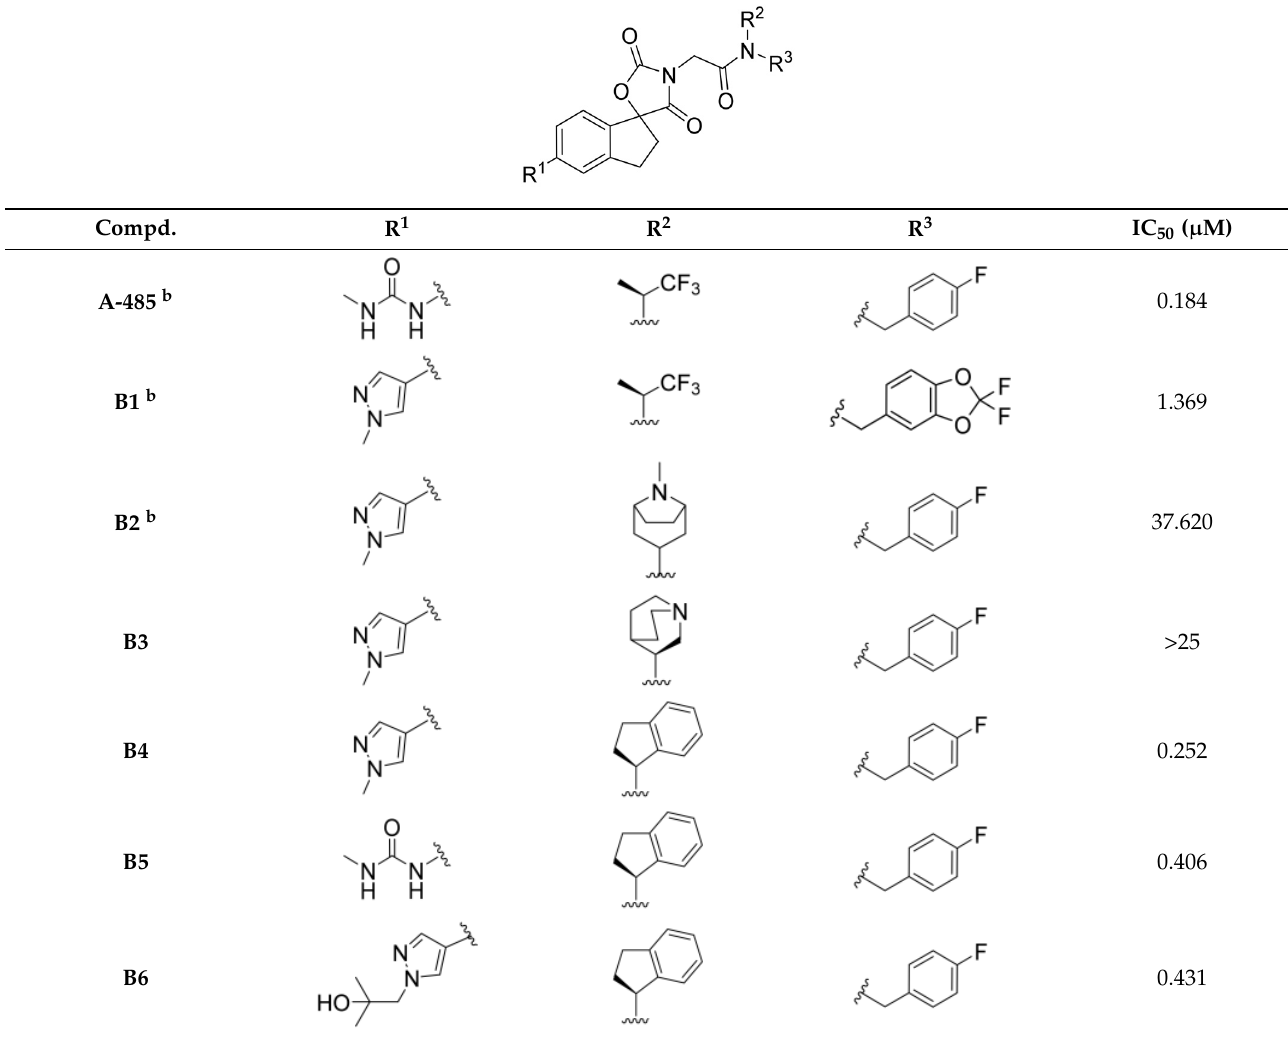
Table 2. Effect of optimization of R1, R2 and R3 on 22Rv1 cell antiproliferation activity a .